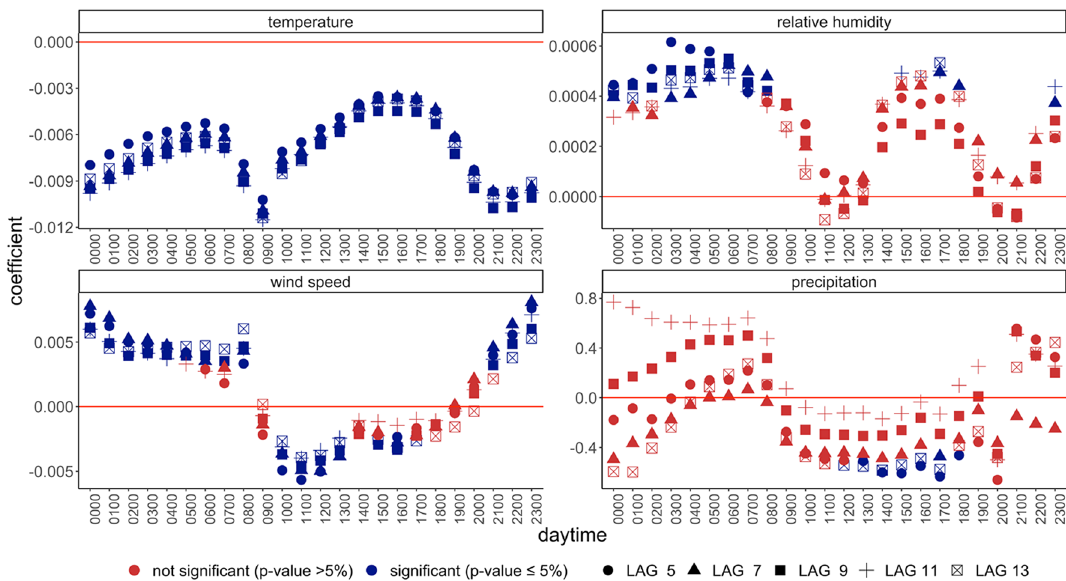
Figure 3. The effect of different weather indicators varies with daytime and is constant across different delay specifications. The effect of different weather indicators at t-7 (at 12:00 local time) on (log) new cases throughout the day with different delay assumptions. The outcome variable is (log) new cases. The x-axis shows different values of the daytime between 00:00 and 23:00 (local time). The shapes of the point estimates indicate the delay between weather and cases variables. Standard deviations of the OLS estimations are based on robust standard errors clustered at the county level. Country and state-date fixed effects applied. N =